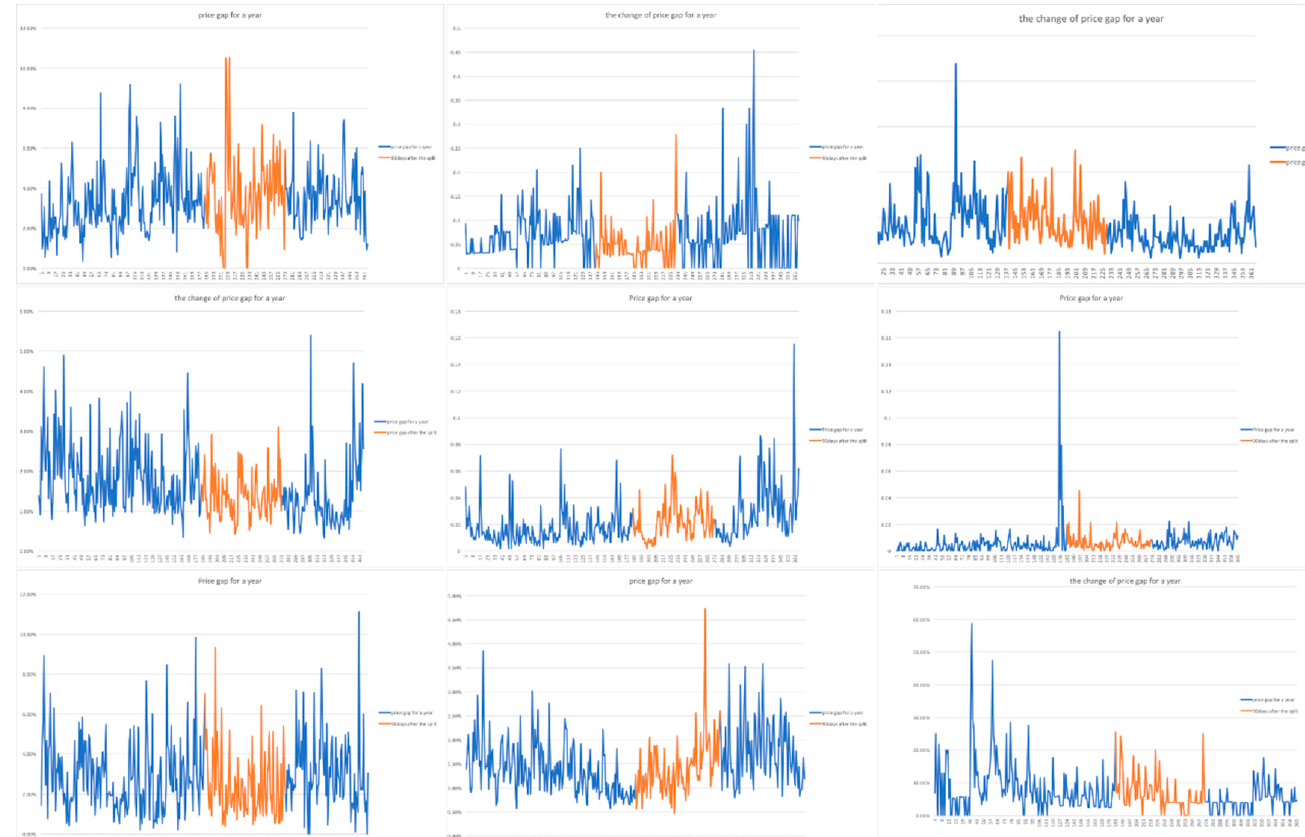
Figure 15 . The price gap half a year before and after the split day: the blue line represents the price gap for the year and the yellow line represents the price gap during the 90 days after the split day.